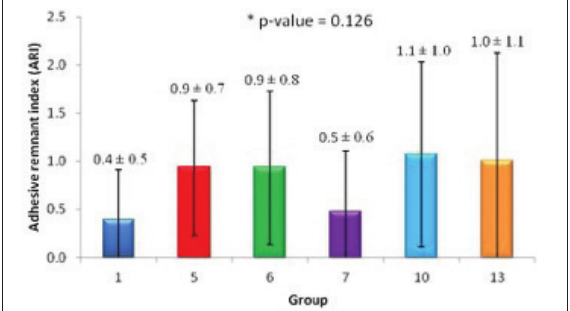
Figure 6. The effect of treatment with bromelain plus papain gel on ARI in comparison with all the conditions of etching and